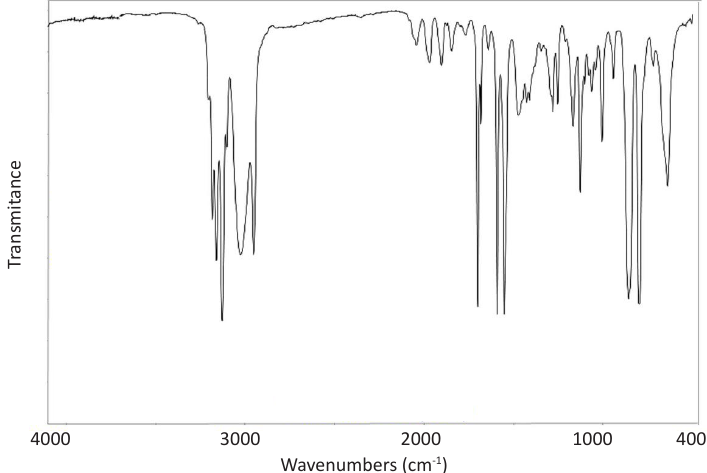
Fig. 7. FT-IR spectrum of PS-Fe